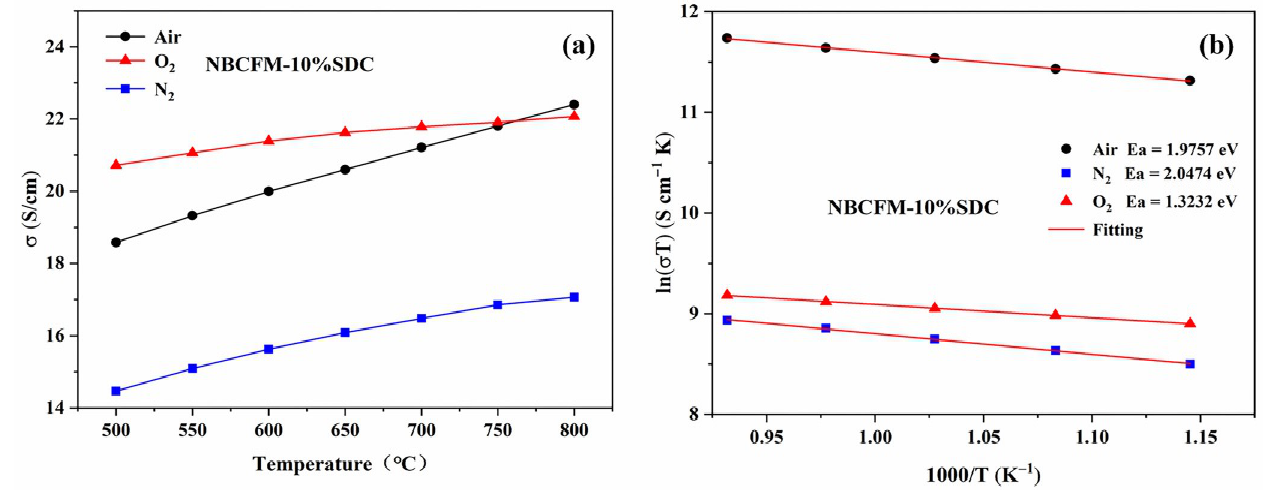
Figure 4. ( a ) Conductivity and ( b ) Arrhenius plots of the electrical conductivity for NBCFM-10%SDC at different temperatures (500–800 ◦ C) in different